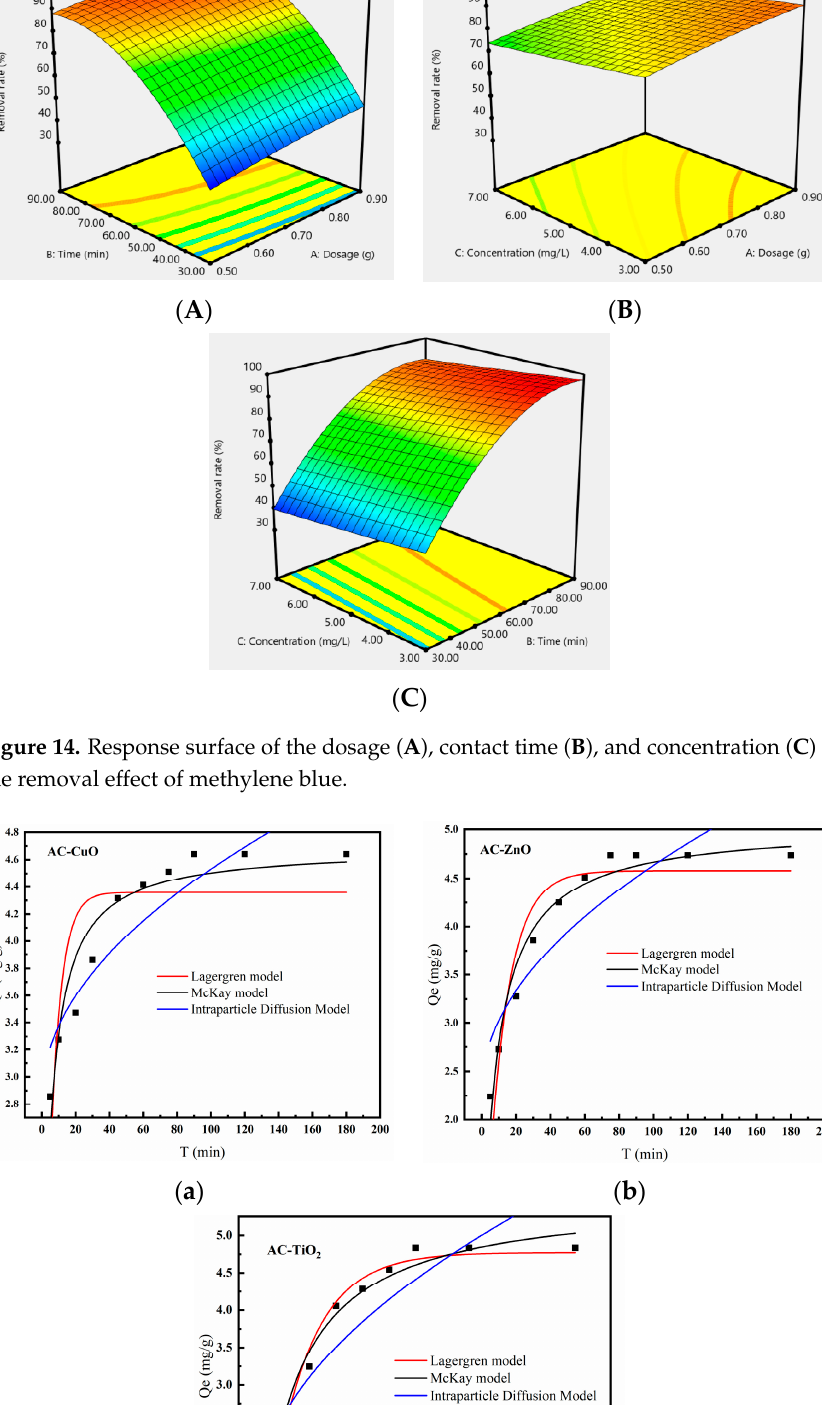
Figure 13. Response surface of the dosage ( A ), contact time ( B ), and concentration ( C ) of AC-ZnO on the removal effect of methylene blue.